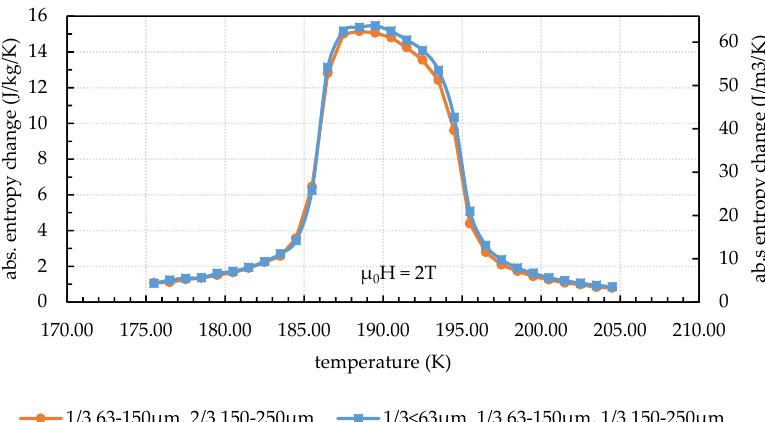
Figure 5. Comparison of the entropy change of plates with different particle size distributions.